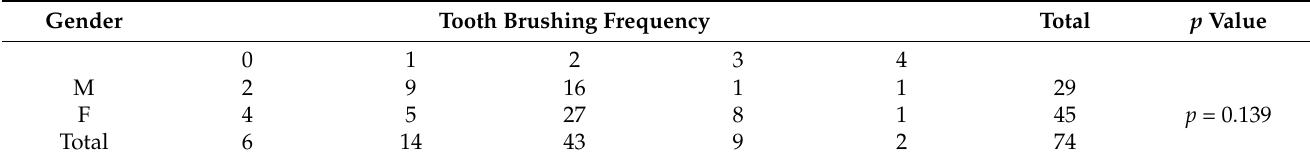
Table 6. Tooth brushing frequency according to gender.